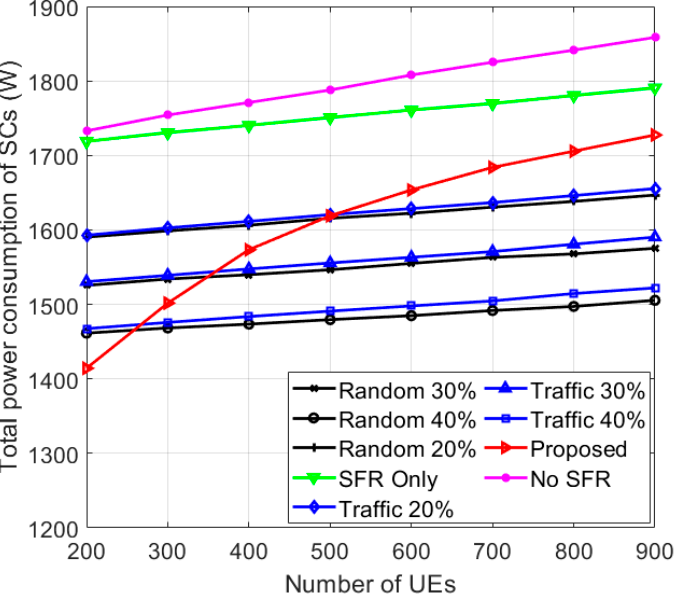
Figure 11. Total system power consumption for different numbers of UEs.